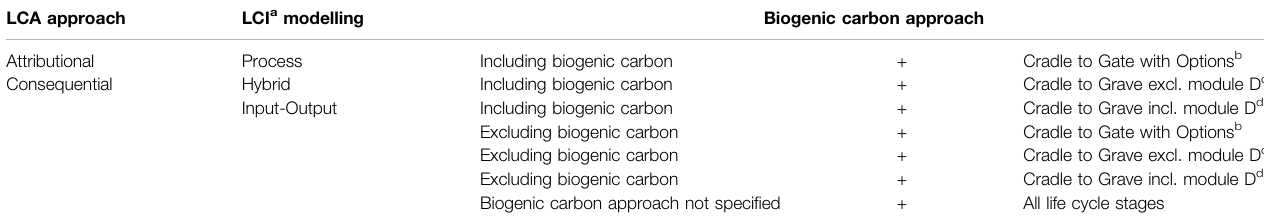
TABLE 2 | Categories as de fi ned in data extraction table regarding LCA approaches, LCI modelling approach and biogenic carbon approaches. LCA approach